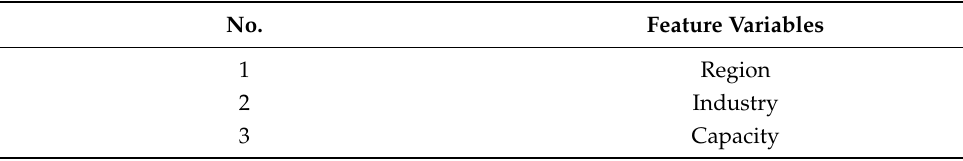
Table 1. Feature variables in the archives dimension.